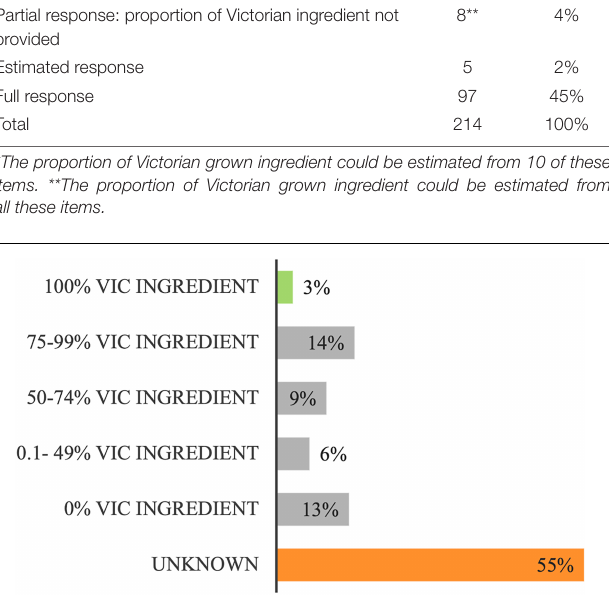
FIGURE 4 | Distribution of the “Australian” food budget ($20,095) according to its proportion of Victorian (Vic)